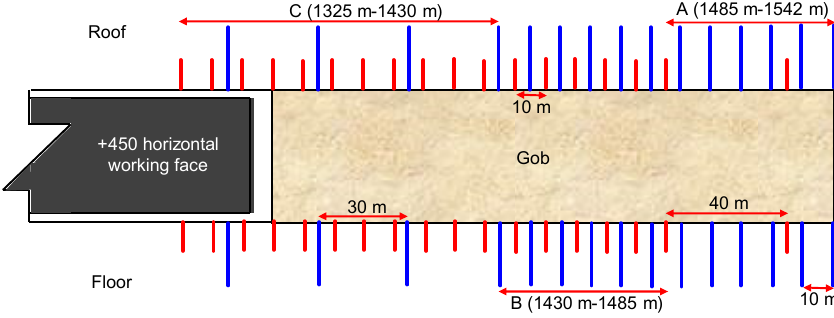
Figure 16. Layout plan of the blasting borehole.